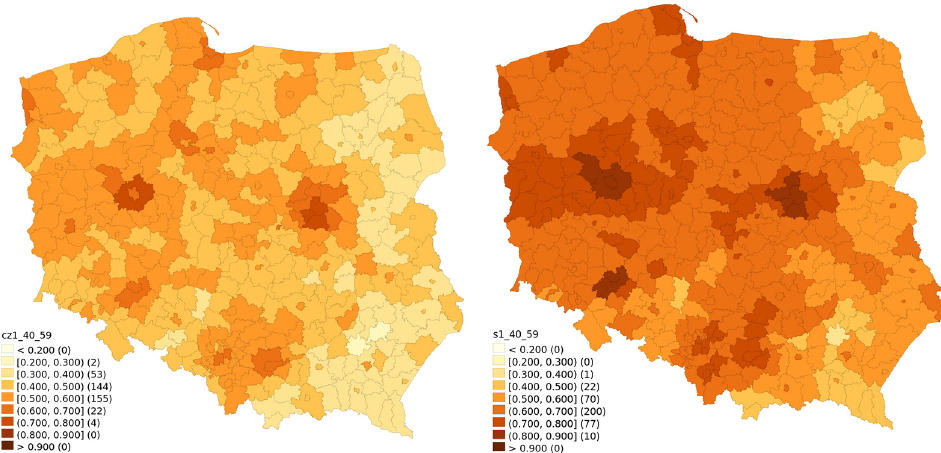
Figure 2. Vaccination rate for the 40–59 age bracket for 30 June 2021 and 31 January 2022.